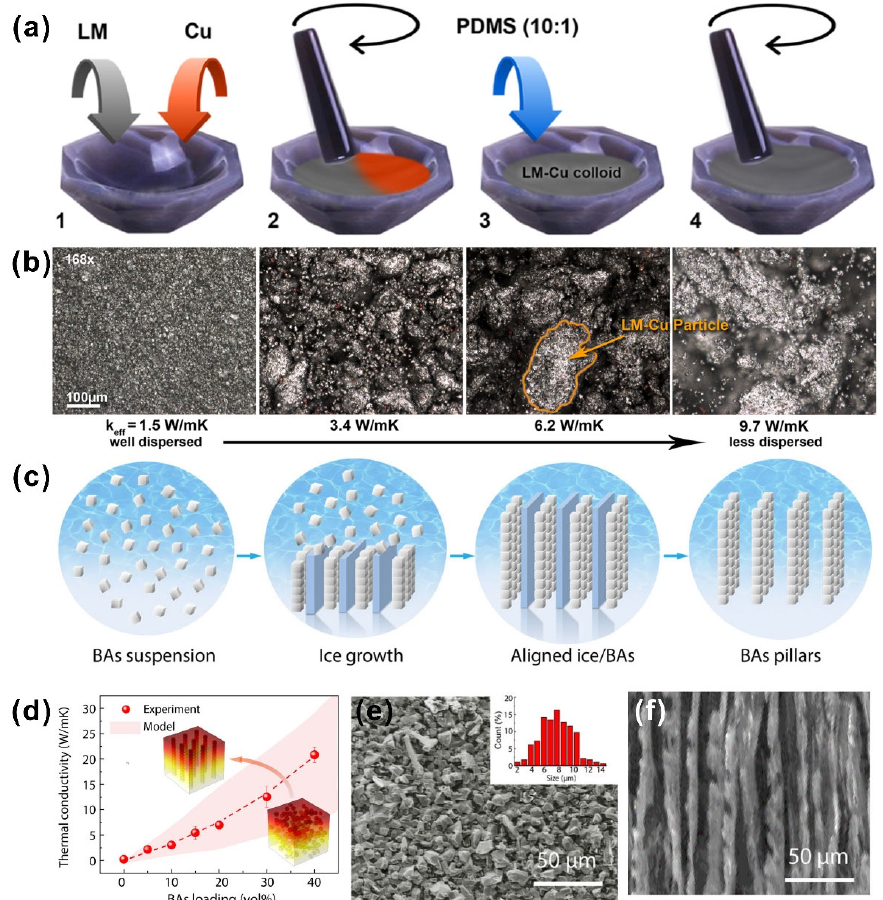
Figure 6. ( a ) The simple mixing method to incorporate the liquid metal and copper powder into polymer matrix. ( b ) The difference in thermal conductivity of as ‐ prepared composite (Figure 6a,b reprinted/adapted with permission from Ref. [100]. 2018, the American Chemical Society). ( c ) The schematic of the growth of aligned structured boron arsenide nanocolumns produced using the di ‐ rectional freeze ‐ drying technique. ( d ) The thermal conductivity of as ‐ prepared composites with dif ‐ ferent boron arsenide loadings. ( e , f ) The microstructural SEM image of the boron arsenide crystals and aligned boron arsenide (Figure 6c–f reprinted/adapted with permission from Ref. [101]. 2021, Springer Nature).